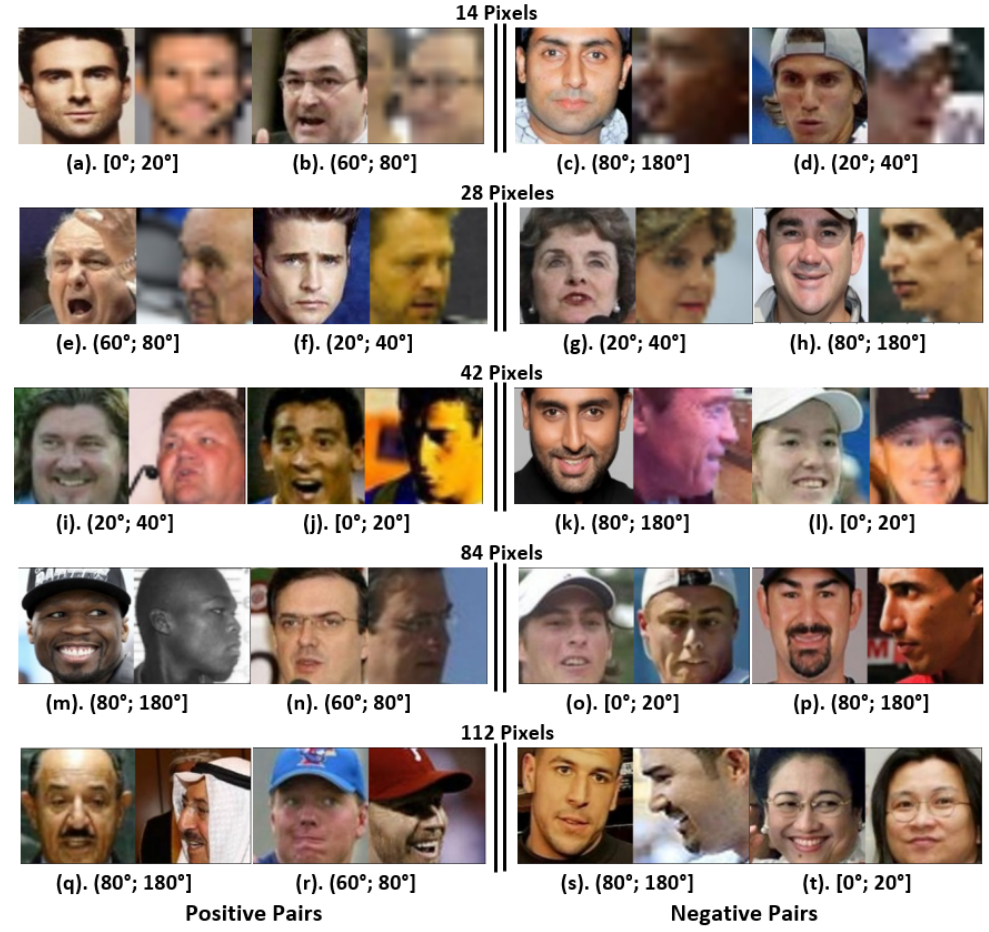
Figure 12. Examples of evaluation subset pairs per resolution interval incorrectly classified by MobileFaceNet.